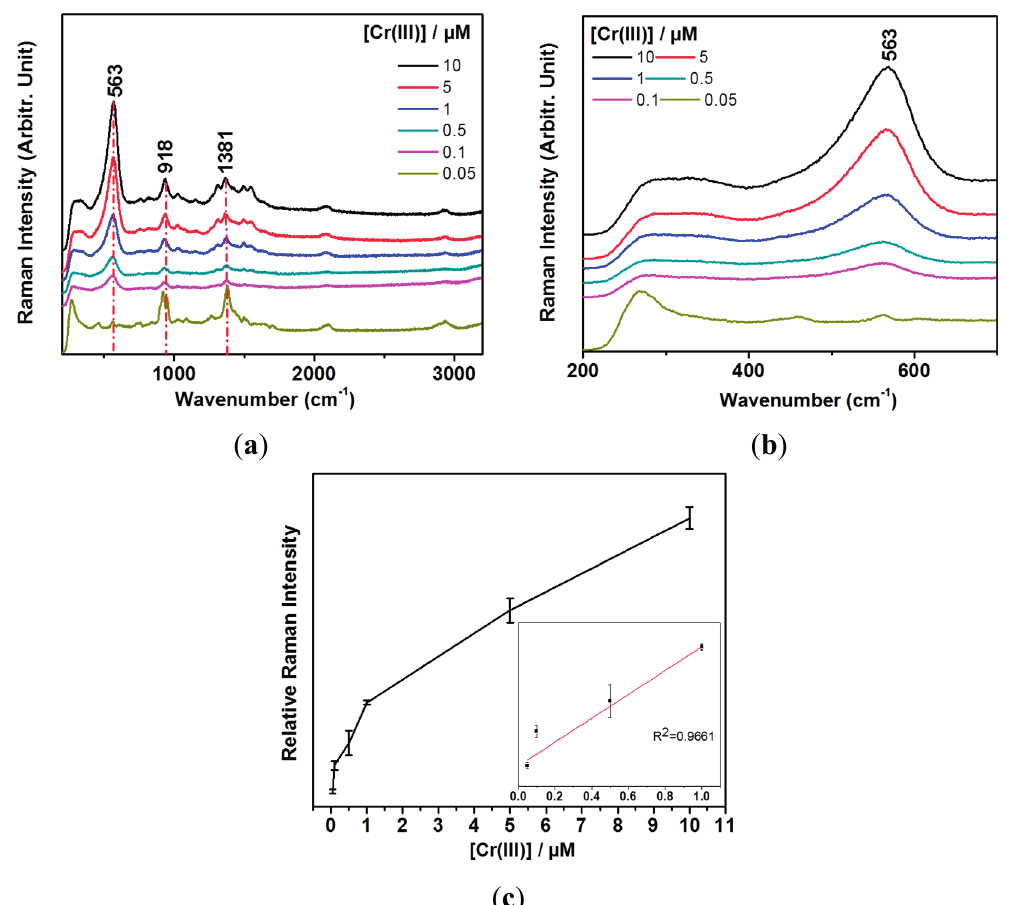
Figure 4. ( a ) Concentration-dependent SERS spectra using AgNPs and Tris-EDTA in the range of 0.005–10 μ M of Cr(III); ( b ) A magnified view of the vibrational bands between 200 and 750 cm − 1 in the Cr(III) concentration-dependent SERS spectra; ( c ) A calibration curve of the vibrational band intensities at ~563 cm − 1 with respect to those at ~918 cm − 1 . The inset shows a linear fitting result for the 0.05 and 1.0 μ M regions.